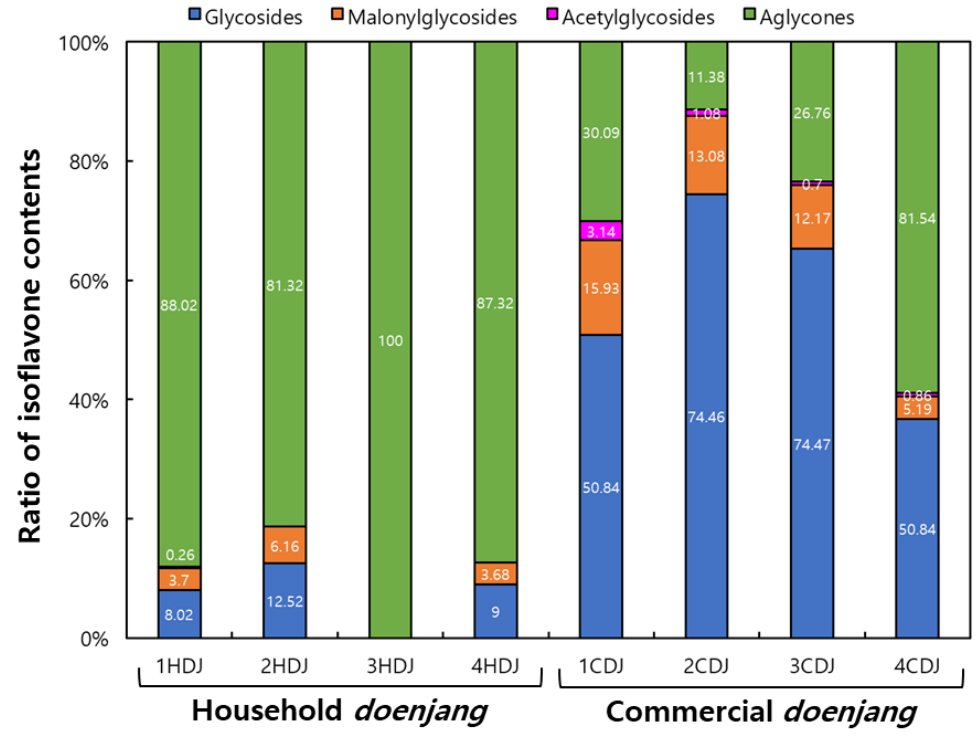
Figure 4. Comparisons of the four isoflavone forms (including glycoisdes, malonylglycosides, acetylglycosides, and aglycones) of 50% MeOH extracts from household and commercial doenjang .